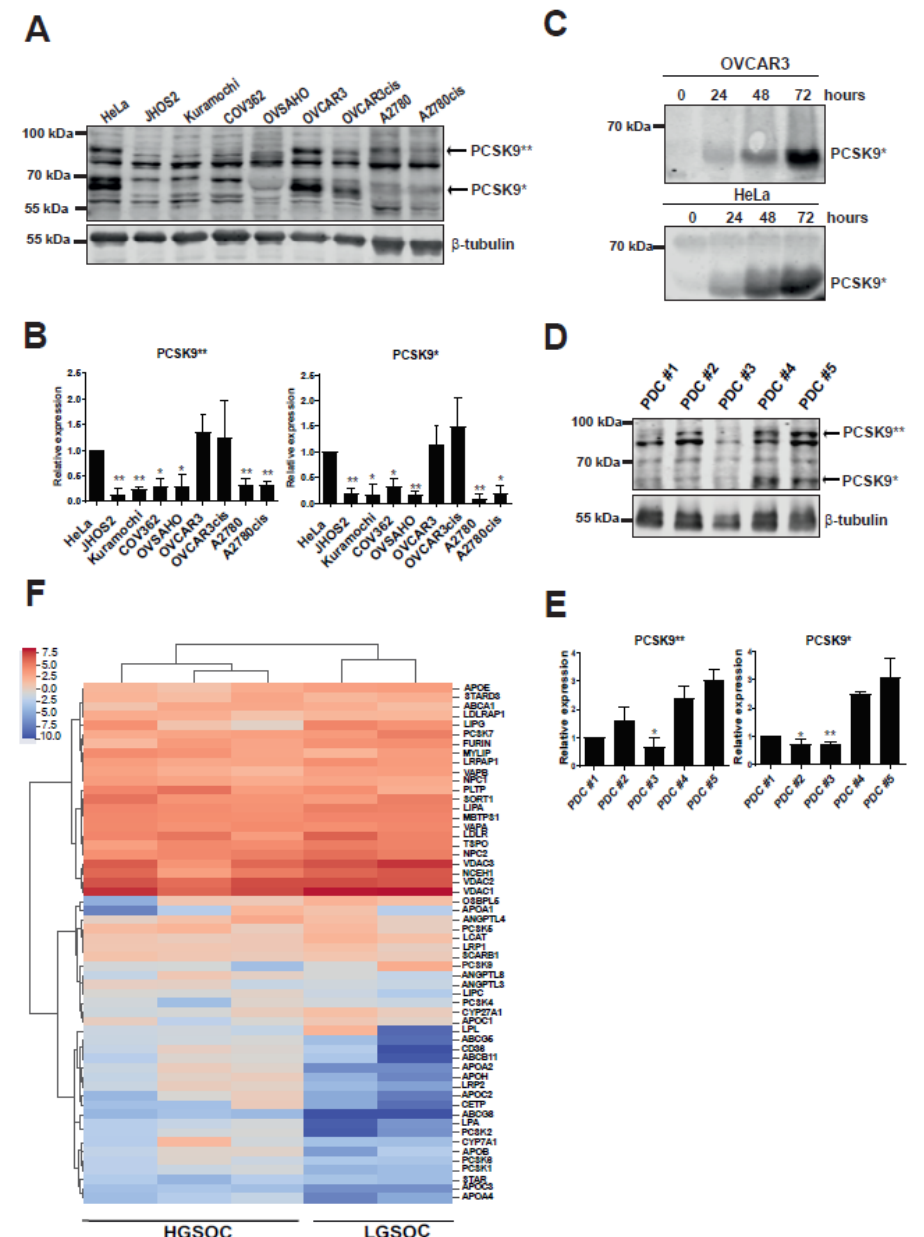
Figure 1. PCSK9 proprotein is expressed in OC. ( A ) PCSK9 protein expression in OC cell lines. Cervical carcinoma HeLa cell line served as positive control. Arrows indicate the molecular weight of cleaved (PCSK9*) and uncleaved (PCSK9**) isoforms. β -tubulin was used as loading control. ( B ) Quantification of PCSK9* and PCSK9** isoform levels from A. Protein levels were normalized to β -tubulin and then compared to PCSK9 isoform levels in HeLa cells (set to 1 for reference point, error bars indicate -/+ SEM of 3 independent experiments. Two-tailed student´s t-test was used to calculate statistical significance, which was indicated as * ( p ≤ 0.05) or ** ( p ≤ 0.01). ( C ) PCSK9* expression in supernatants of OVCAR3 and HeLa cells detected at various time points as indicated. ( D ) Western blot analysis of PCSK9* and PCSK9** isoform expression in lysates of OC PDCs. ( E ) Quantification of PCSK9* and PCSK9** isoform levels from ( D ). An arbitrary value of 1 was given to PCSK9 isoform levels in PDC#1. Error bars indicate − /+ SEM of 3 independent experiments. The statistical analysis was performed as in ( B ). ( F ) Hierarchical clustering of KEGG defined PCSK family and lipid-associated gene expression pathways of the low-grade serous ovarian carcinoma (LGSOC) and high-grade serous ovarian carcinoma (HGSOC) PDCs. Values are presented as log2 transformed transcripts per kilobase million (TPM) from RNA-seq from five PDCs. The uncropped Western Blot images can be found in Figure S1, and signal values are listed in Table